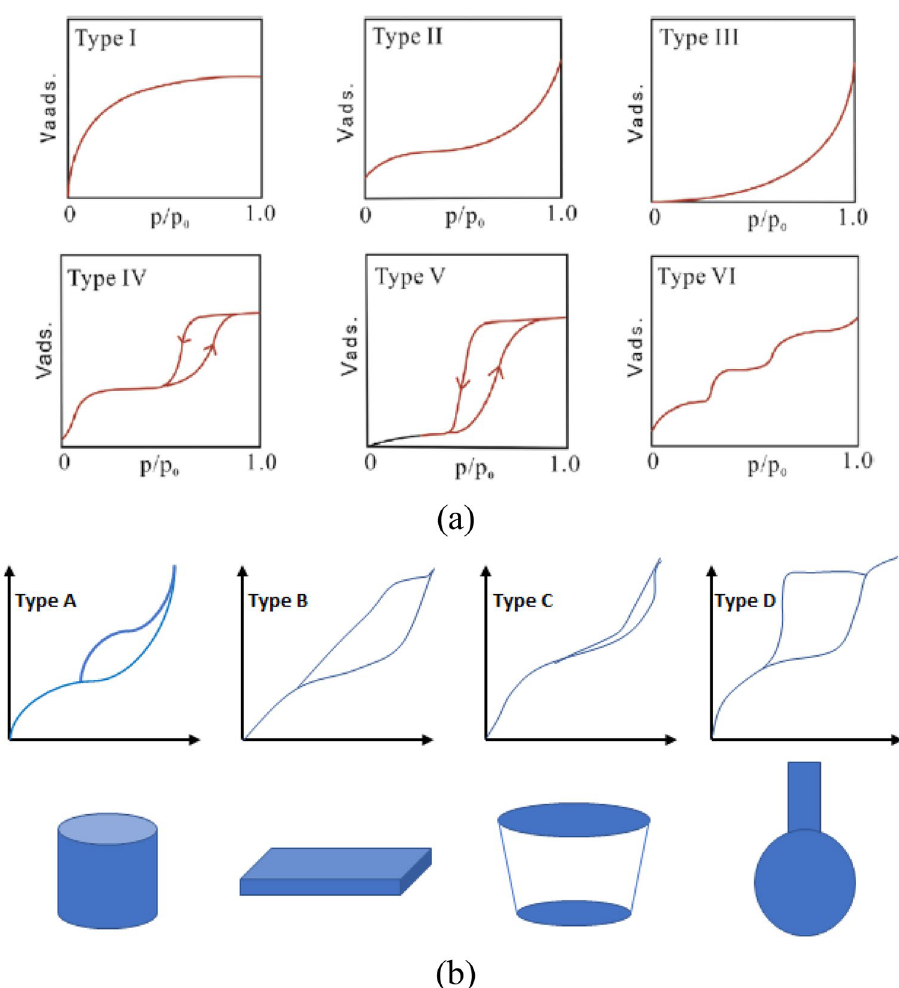
Figure 4. Adsorption isotherms types ( a ) and classification of hysteresis loops and their related pore shapes ( b ) 60,61